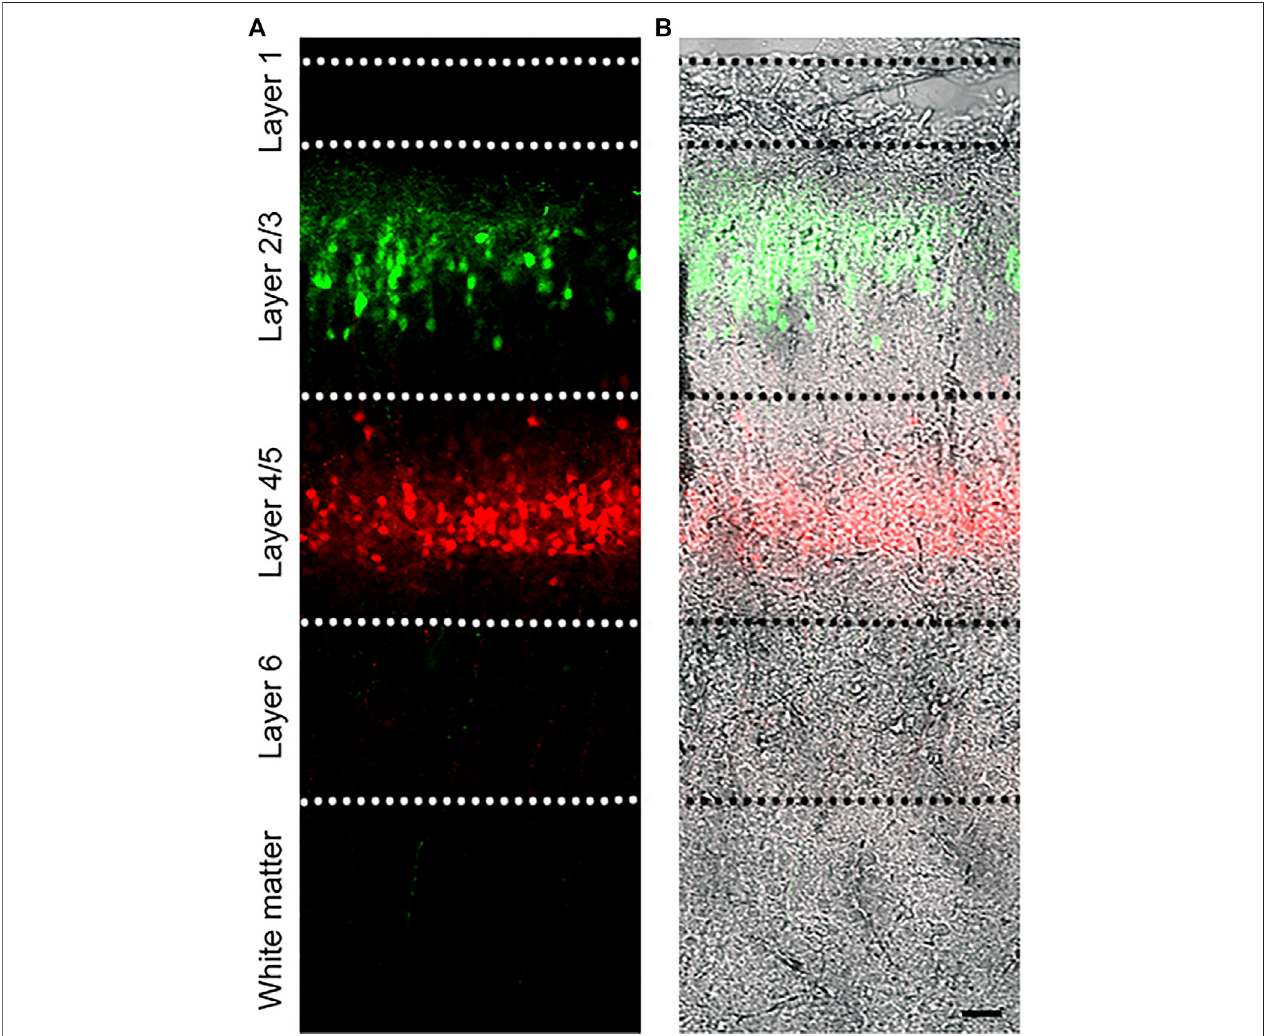
FIGURE 1 | Dual IUE image in the SSC. (A) : Image of a postnatal day (P) 14 mouse coronal section containing GFP-expressing L2/3 cortical neurons and tdTomato-expressing L4/5 neurons following IUE at E15.5 and E13.5, respectively. (B) : Fluorescent image overlaid with bright fi eld. Bar: 50 µm.